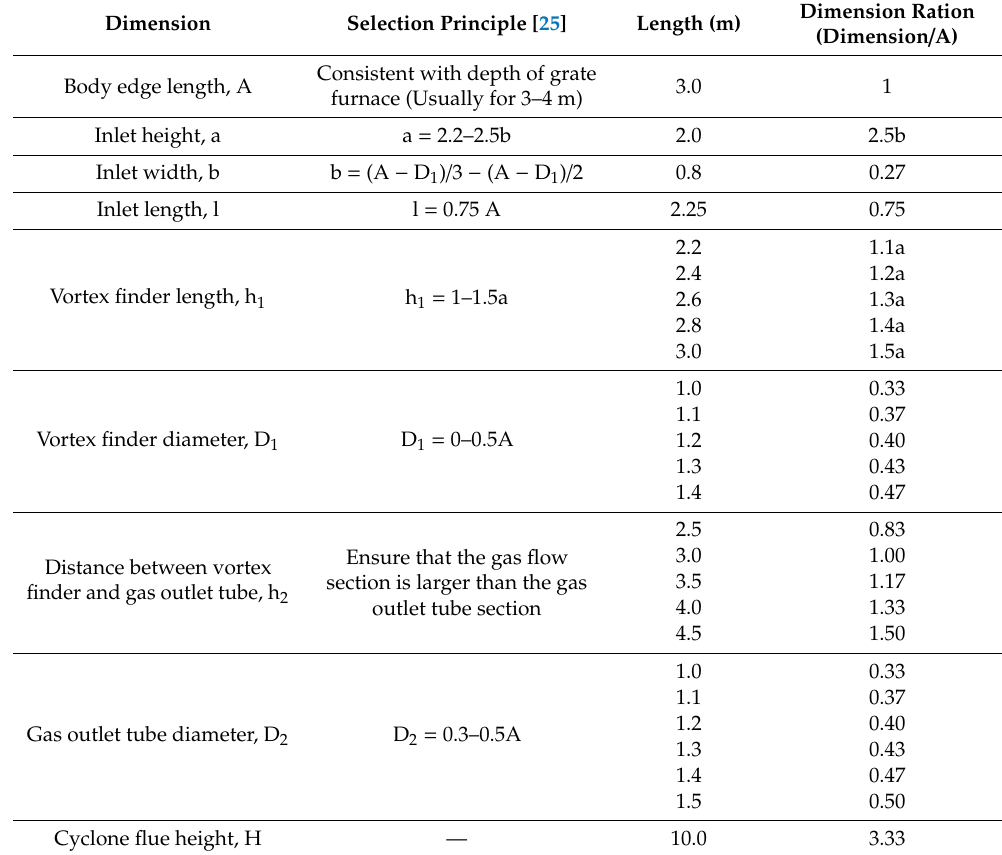
Figure 2. Structure diagram of adiabatic cyclone flue: ( a ) Three-dimensional structure diagram, ( b ) Profile diagram. Table 1. Dimension of the adiabatic cyclone flue.